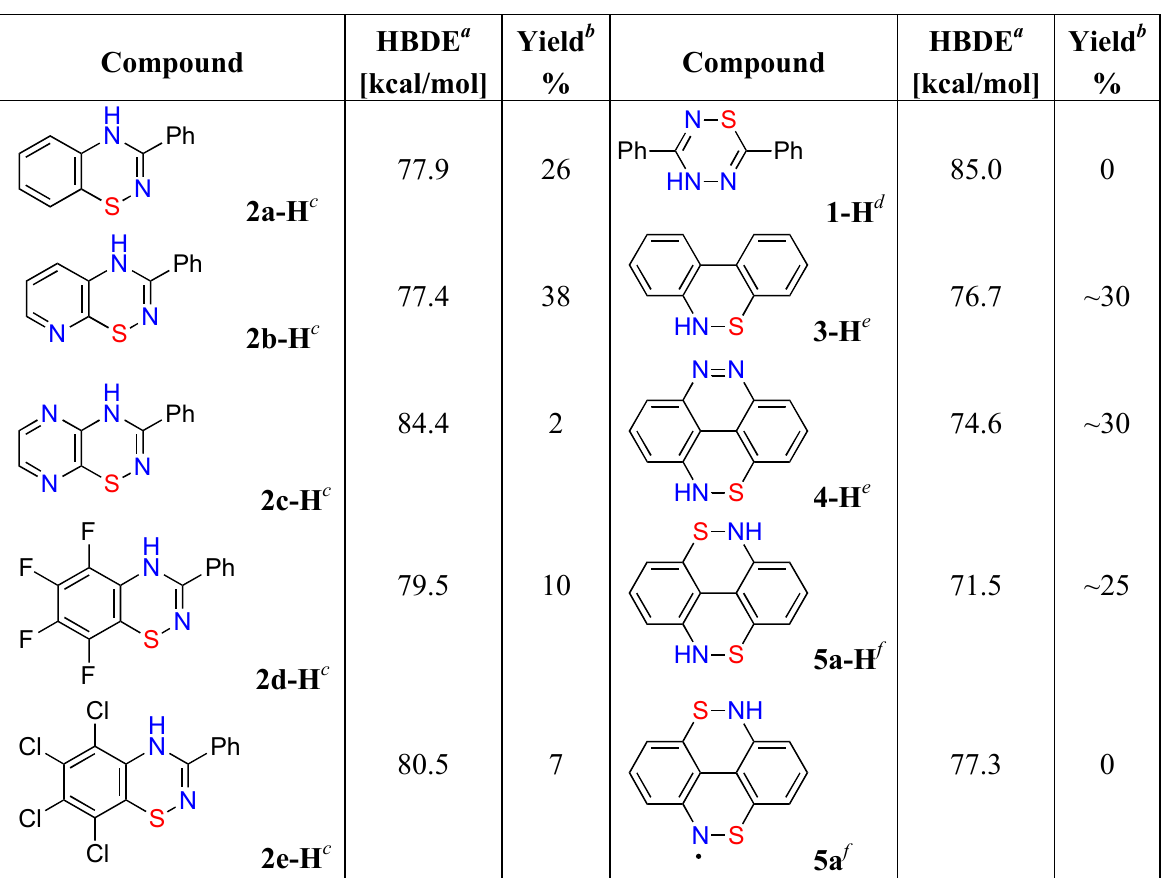
Table 1 . Calculated N-H Homolytic Bond Dissociation Energies (HBDE) and yields of radicals for selected compounds relative to